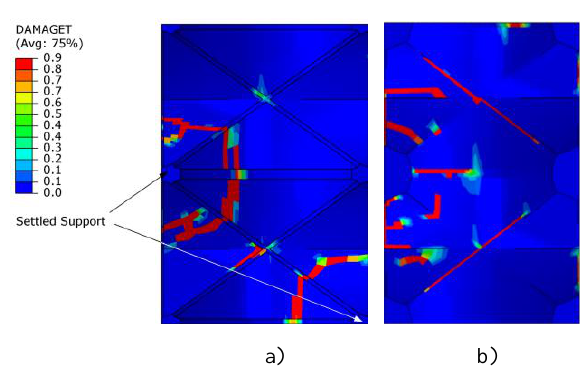
Figure 13. Damage simulation due to combination of asymmetric vertical support settlements applied in two stages: a) intrados view, b) extrados